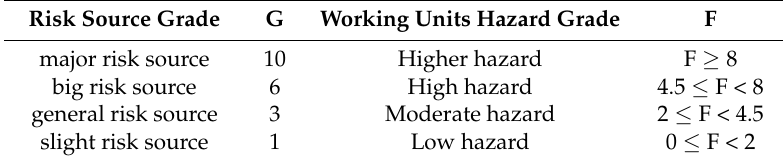
Table 4. Risk source grade and working units hazard grade and score corresponding table. Risk Source Grade G Working Units Hazard Grade